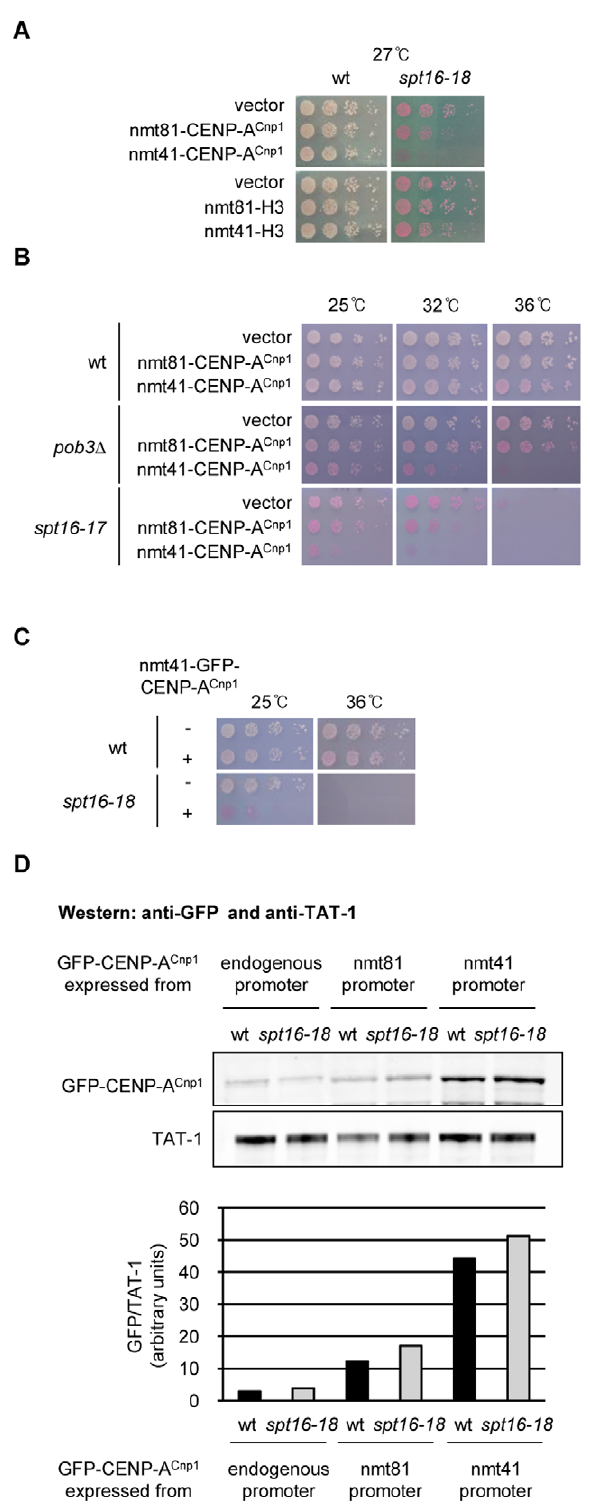
Figure 1. Overexpression of CENP-A Cnp1 causes toxicity in FACT mutants. (A) Viability of wild-type (wt) and spt16-18 cells expressing additional CENP-A Cnp1 or H3 at low (nmt81-CENP-A Cnp1 , nmt81-H3) or medium (nmt41-CENP-A Cnp1 , nmt41-H3) levels compared to empty vector. Cells were grown at 27 u C which is semi-permissive for spt16-18 . Phloxine B plates stain dead cells red. (B) Viability of wt, pob3 D and spt16-17 cells expressing additional CENP-A Cnp1 at low